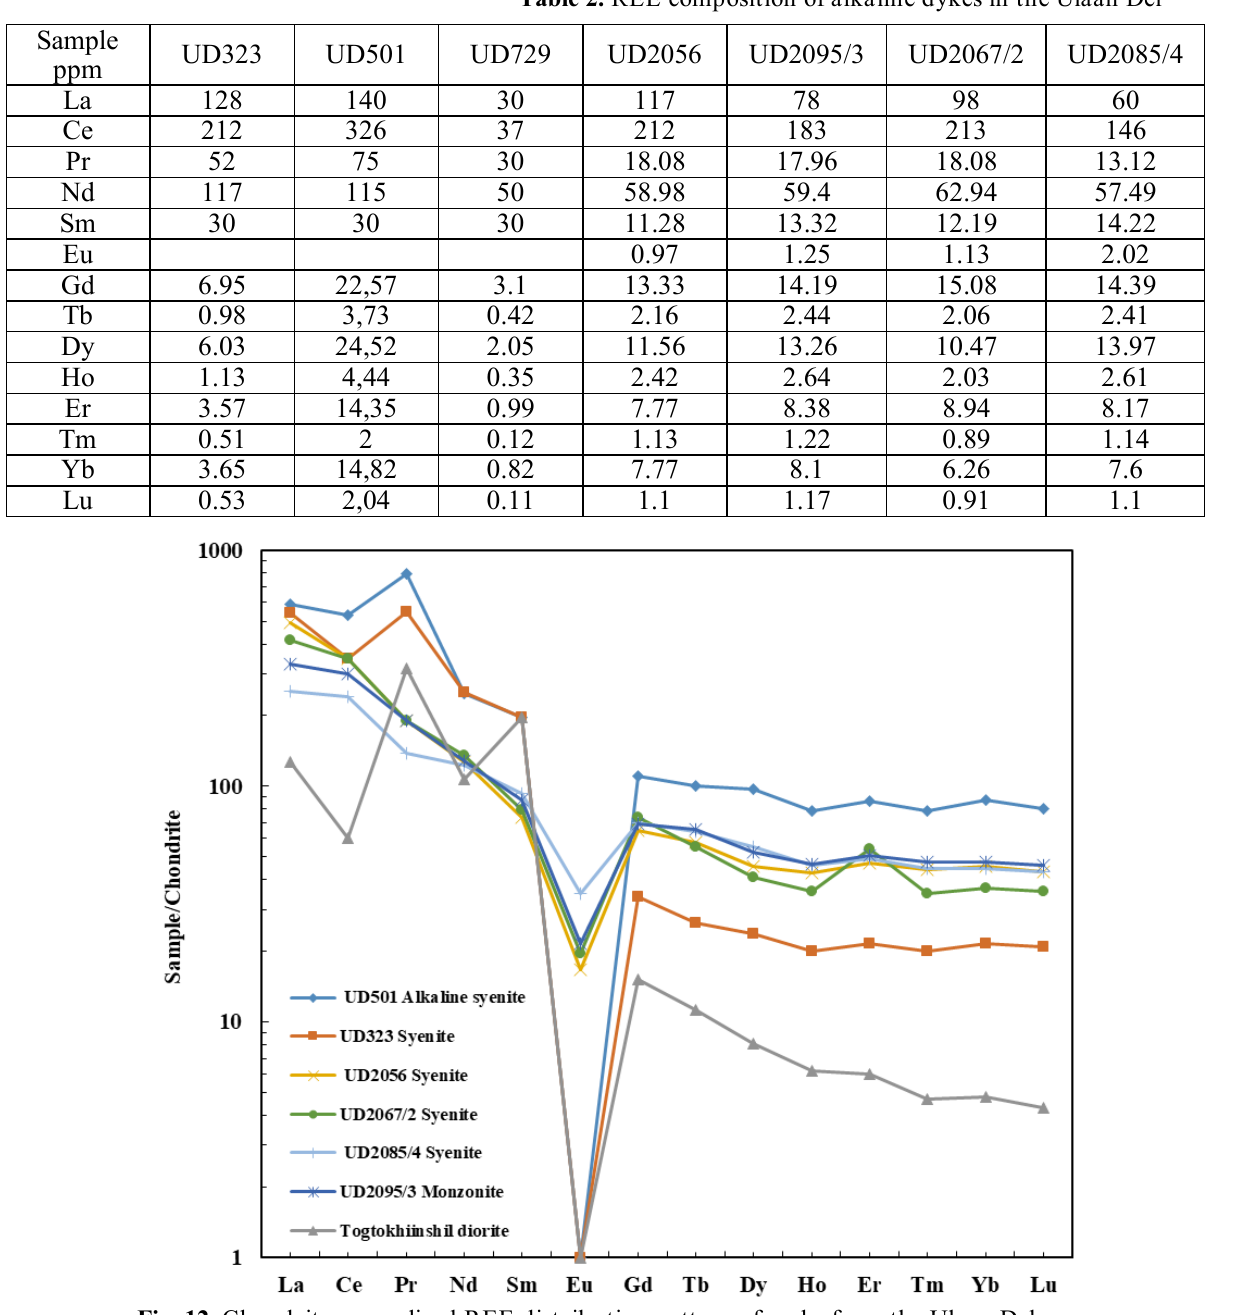
Fig. 12. Chondrite normalized REE distribution pattern of rocks from the Ulaan Del area. (C1 chondrite normalization by Sun and McDonough, 1989)